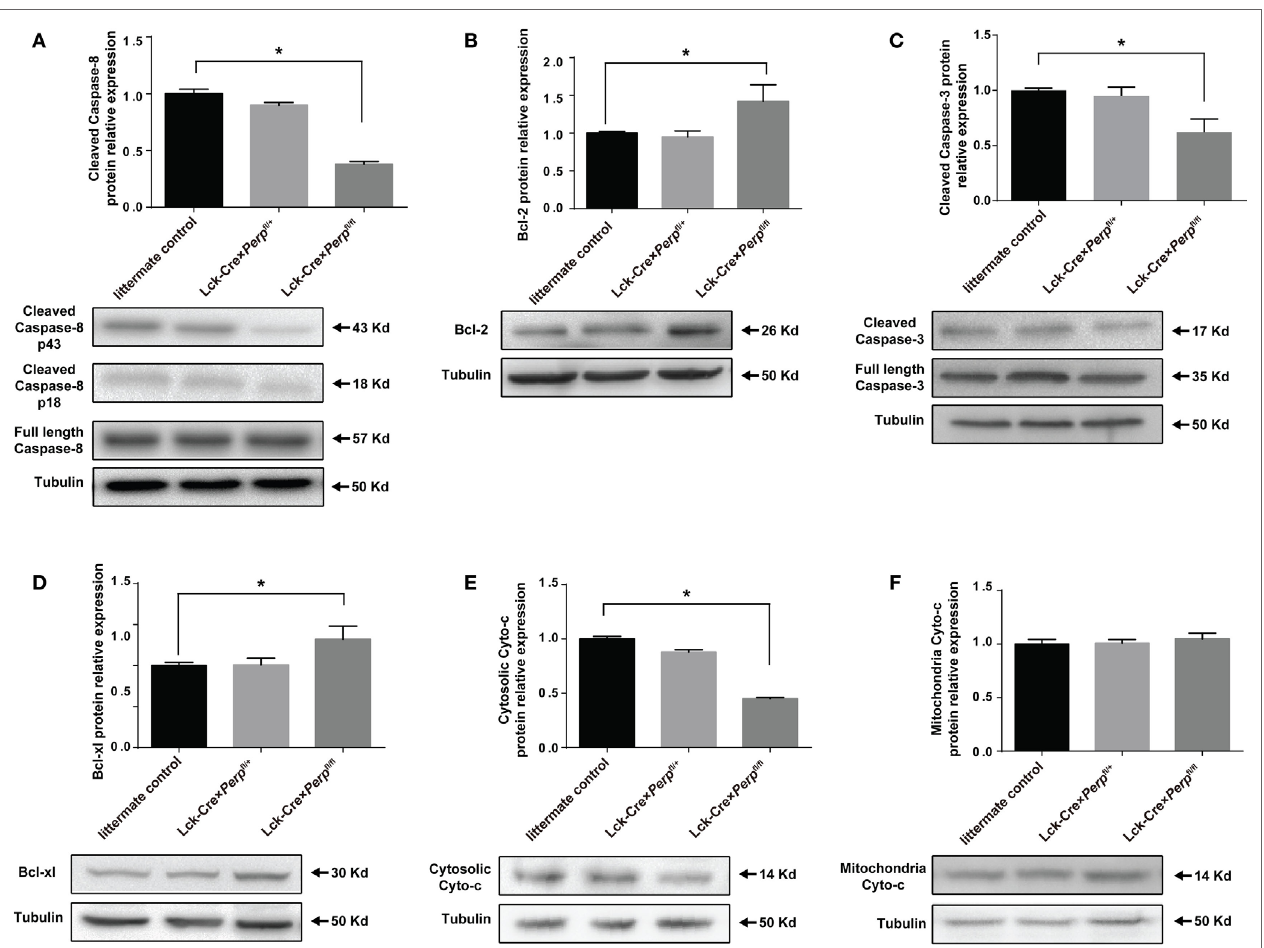
FigUre 3 | Perp − / − in T cells promotes the resistance of T helper 17 (Th17) cells to apoptosis in a caspase-dependent manner. Following induction of apoptosis, the relative levels of cleaved caspase-8 (a) , Bcl-2 (B) , cleaved caspase-3 (c) , Bcl-xL (D) , cytosolic cytochrome (cyto- c ) (e) , and mitochondrial cyto- c (F) to the control tubulin expression in the different groups of Th17 cells were determined by Western blot. Data are representative images or expressed as the mean ± SEM of each group from three separate experiments (* P <